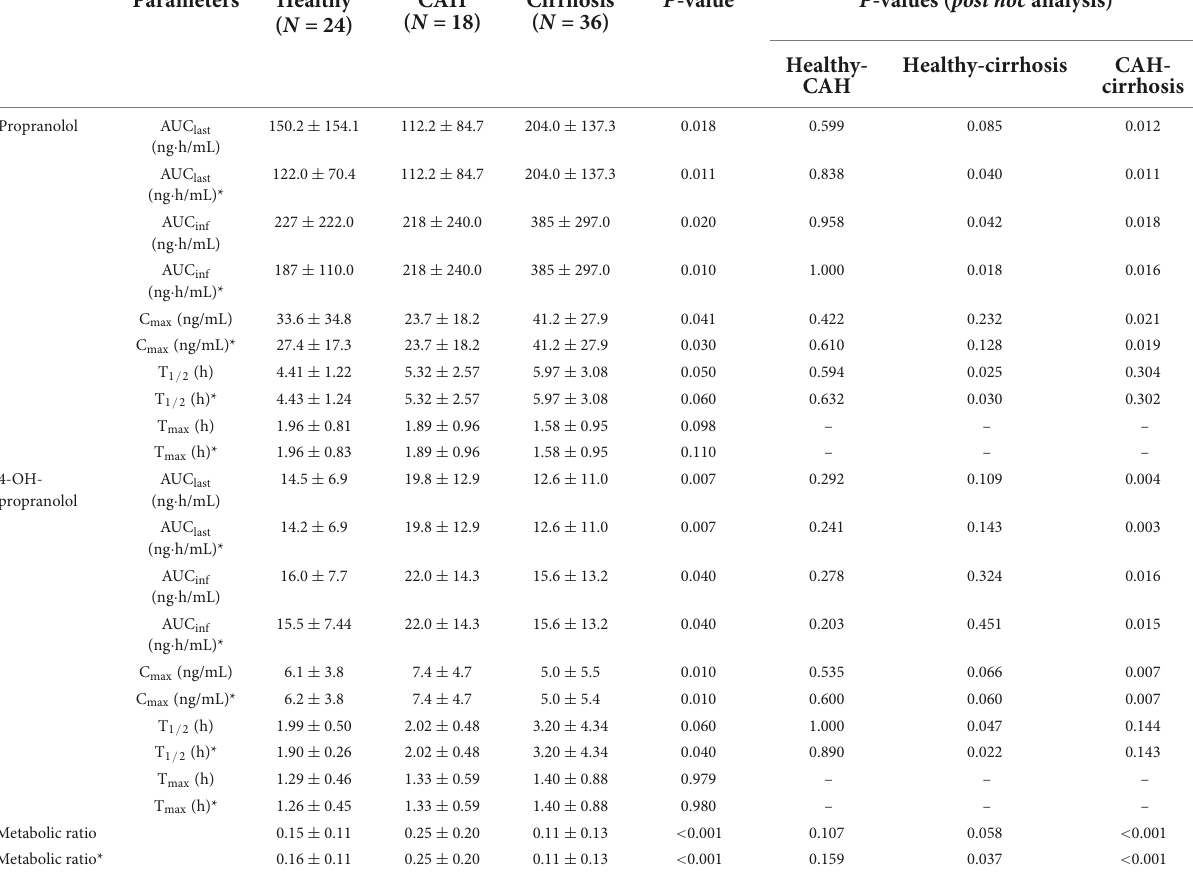
TABLE 2 Pharmacokinetic parameters of propranolol and 4-OH-propranolol by subject group.